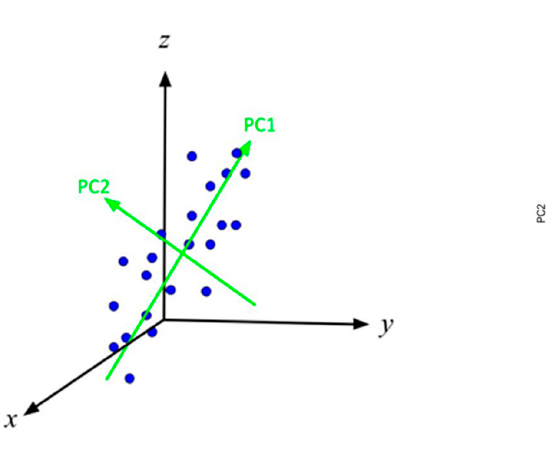
data points based on similarity, in the sense that in K ‐ means clustering, the number of clusters can be pre ‐ specified so that the genes are specified into k clusters, while in hierar ‐ chical clustering, the number of clusters is not pre ‐ specified. Hierarchical clustering out ‐ puts a dendrogram, a tree ‐ like visual representation of each possible number of clusters, from 1 to n , with n as the total number of objects in the dataset. Furthermore, hierarchical clustering shows a detailed relationship between the genes, making it more beneficial than K ‐ means clustering. In hierarchical clustering, at the very top of the dendrogram is the most general cluster. Lower on the dendrogram, the genes in the cluster are more similar to one another, compared to those connected on the top. To illustrate this, Figure 7 shows